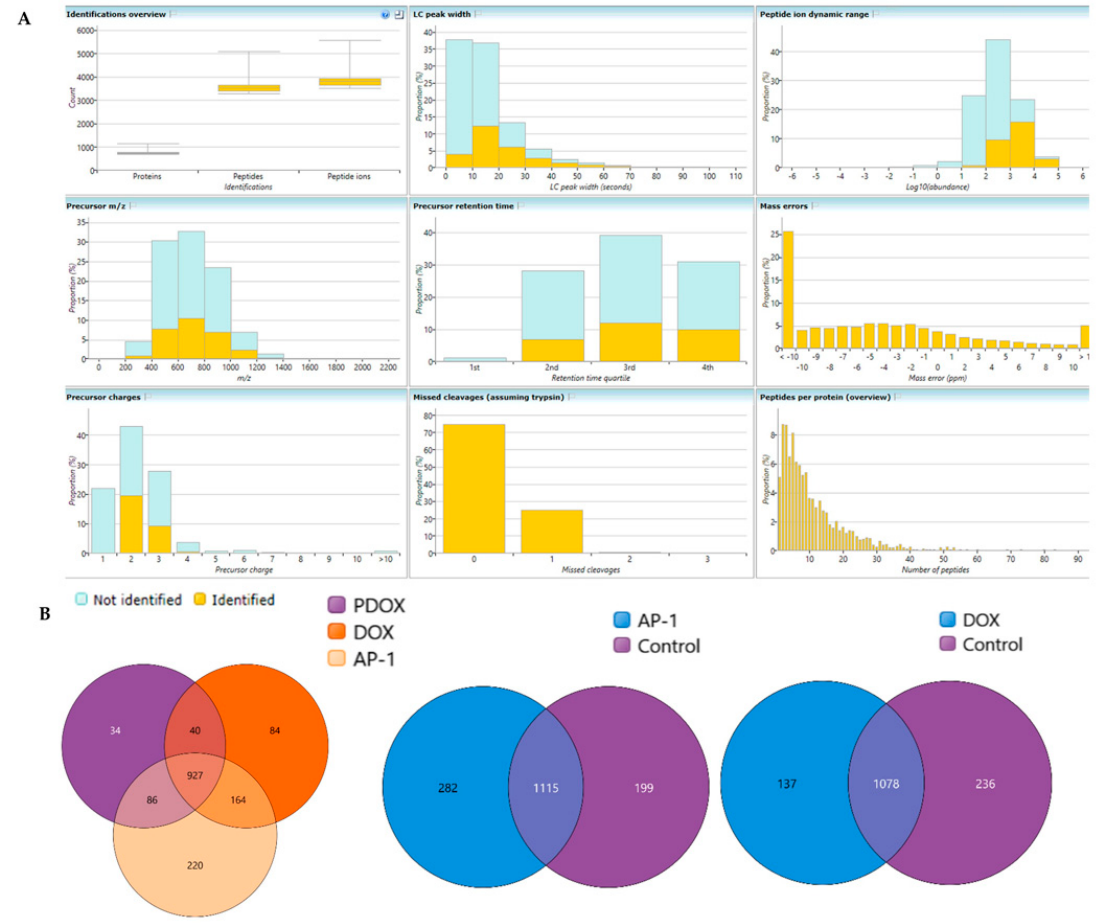
Figure 8. ( A ) Overview of quality control metrics of LC-MS/MS shotgun proteomic study of the MCF7 cells after treatment with AP-1, DOX and their synergistic combination (PDOX). ( B ) Venn diagrams of the overlapped identified proteins in the differently treated